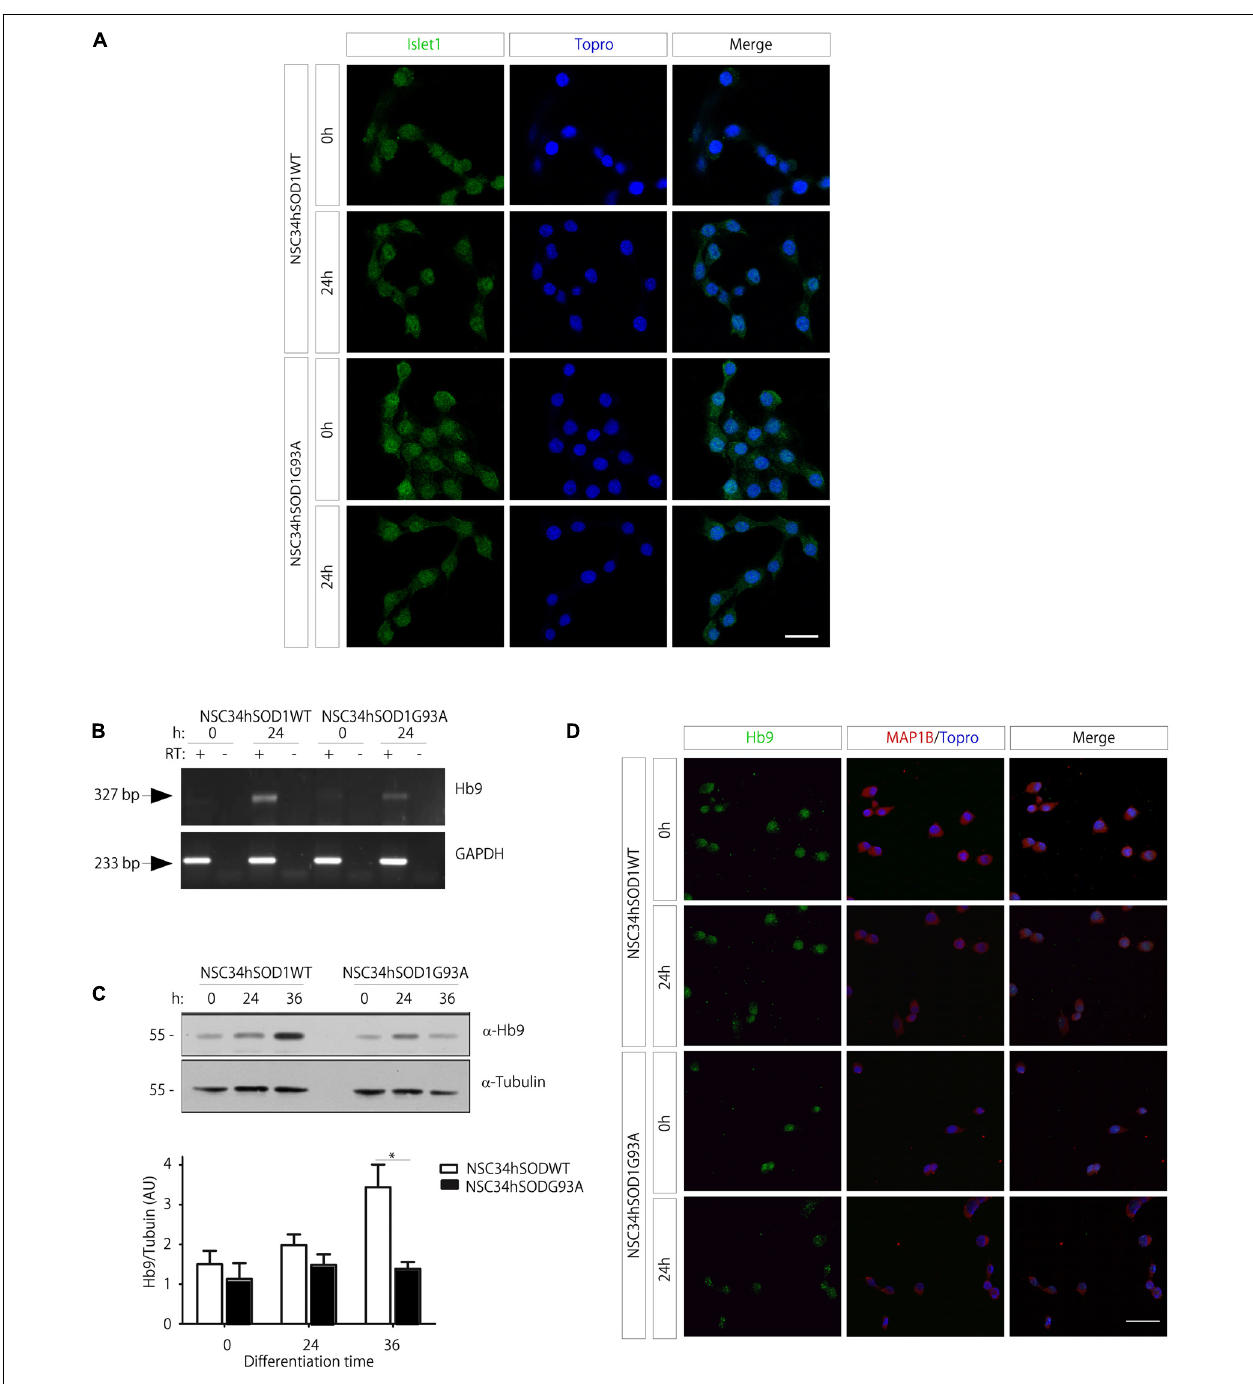
FIGURE 5 | Expression of motor neuron cell markers in NSC34hSOD1 cells. (A) NSC34hSOD1 cells were seeded onto glass coverslips and differentiated for 24 h. Immunocytochemical analyses show that Islet-1 is localized at the cell nuclei, which were counterstained withToPro-3. (B) Total RNA was extracted at 0 and 24 h of NSC34hSOD1 cell differentiation, and subsequently subjected to reverse transcription (RT + ) to obtain cDNA. As a control, the same reaction was performed in the absence of reverse transcriptase (RT − ). PCRs were performed with specific primers to amplify